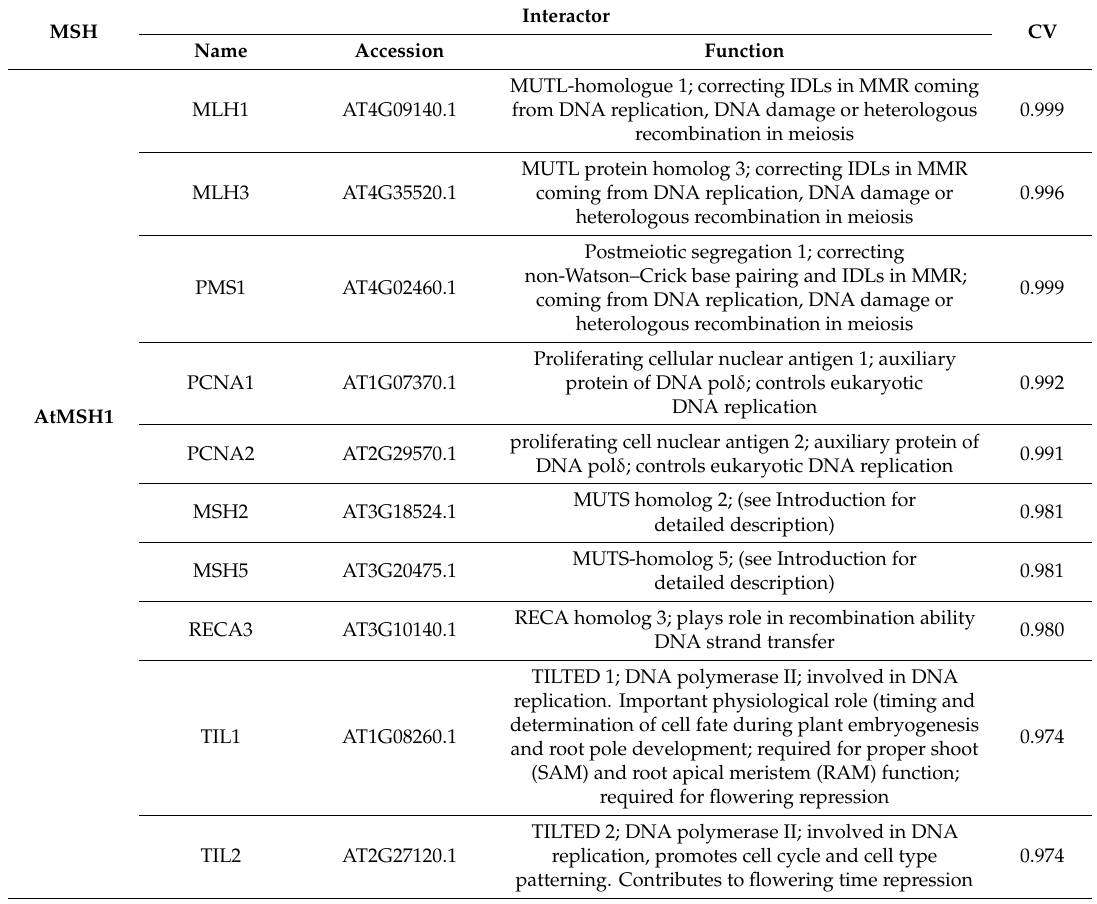
Table 4. Interactors of AtMSH proteins as retrieved by interactome analysis in